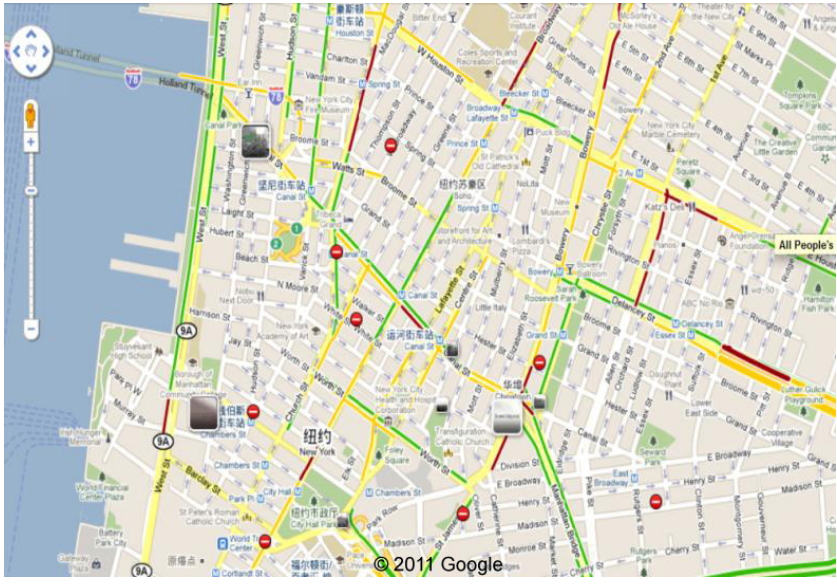
Figure 9. Near real-time traffic map in New York City on April 17, 2011 based on the Google